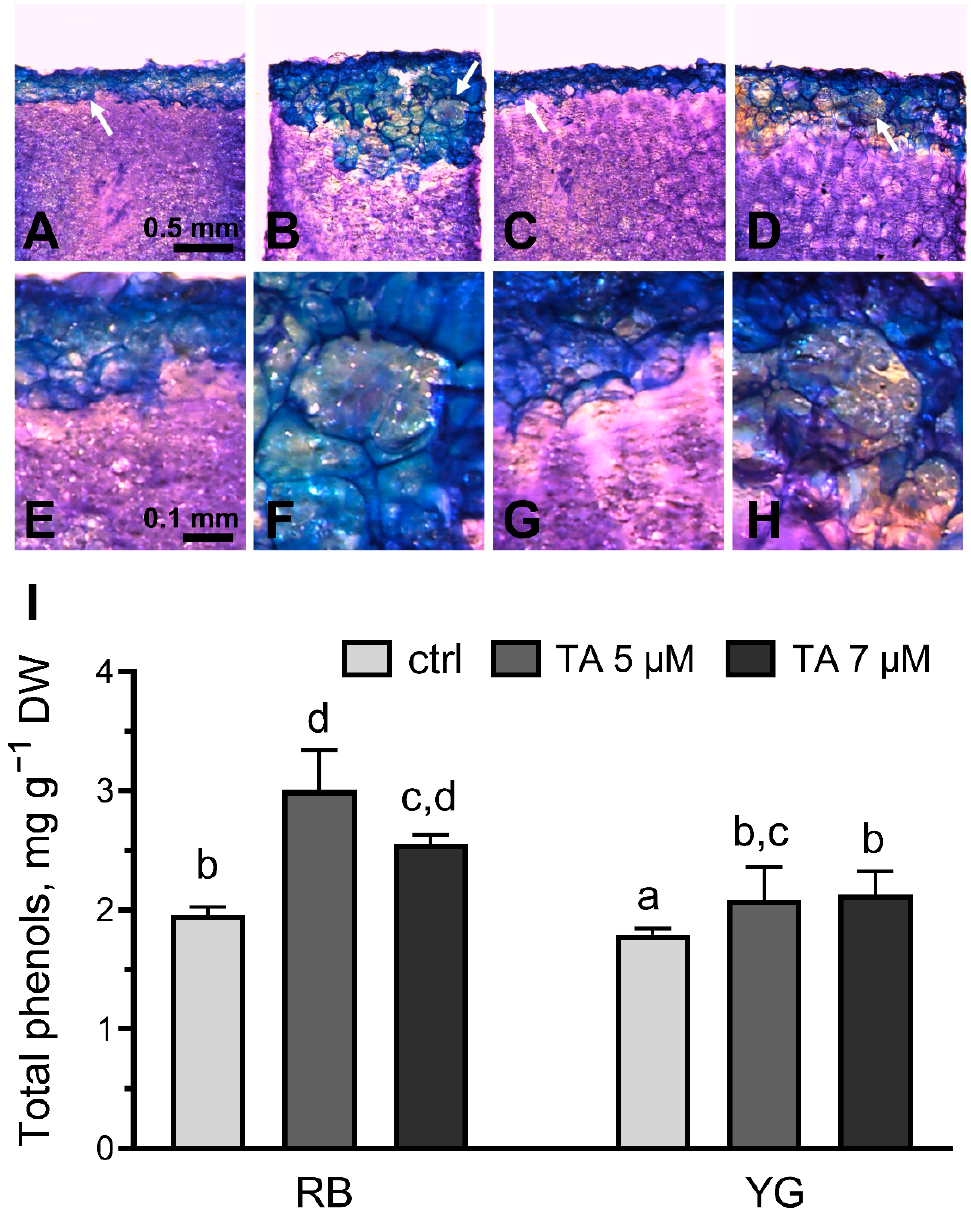
Figure 4. TA induces accumulation of phenolic compounds in tuber parenchyma. ( A – H ) Toluidine blue O staining of MeOH and TA (7 µ M) treated tuber tissue, 9 days after treatment. ( A – D ) Phenolic deposits on the tuber slice surface after MeOH and TA treatment; ( E – H ) Close-up view of changes in cell morphology indicated by the white arrows in A-H; ( A , E ) RB slice treated with MeOH; ( B , F ) RB tuber slice treated with TA; ( C , G ) YG tuber slice treated with MeOH; ( D , H ) YG tuber slice treated with TA; ( I ) Total phenols (mg g − 1 dry weight [DW] of tuber parenchyma tissue) extracted from the 5 µ M and 7 µ M TA-treated areas and control (ctrl) area of RB and YG tuber slices. Values are the means ± SEM (n = 3). Different letters (a–d) indicate significantly different means according to two-way ANOVA followed by Fisher’s LSD ( p ≤